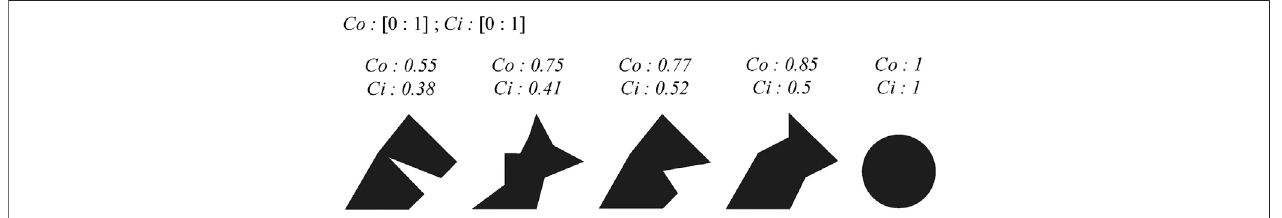
FIGURE 4 | Test shapes demonstrating associated circularity and convexity values.